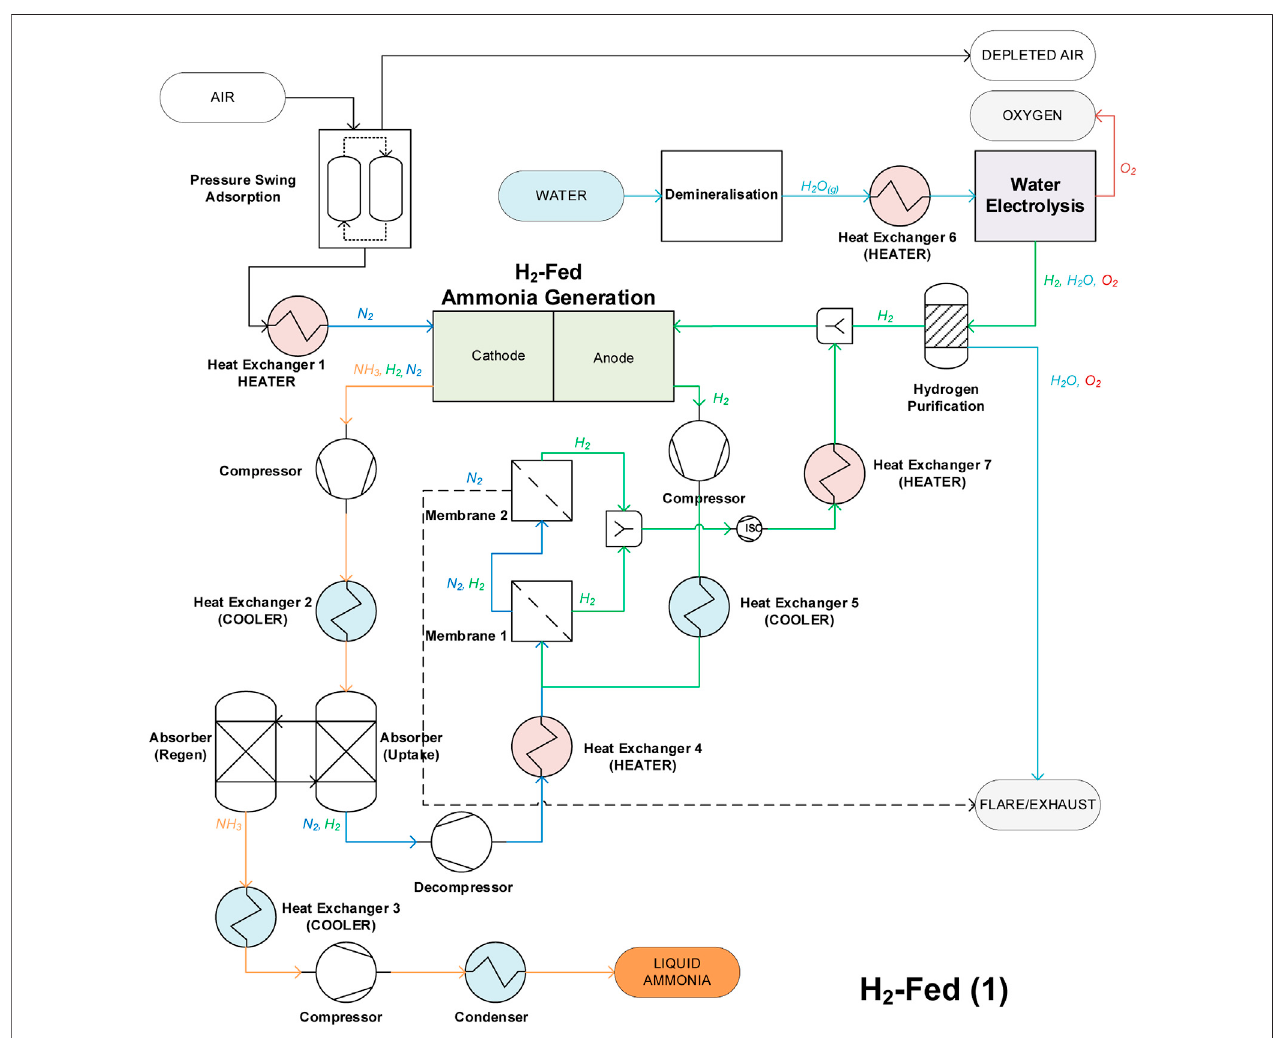
FIGURE 3 | Hydrogen-fed process fl ow arrangement [H 2 -fed (1)] including anode stream recycle.